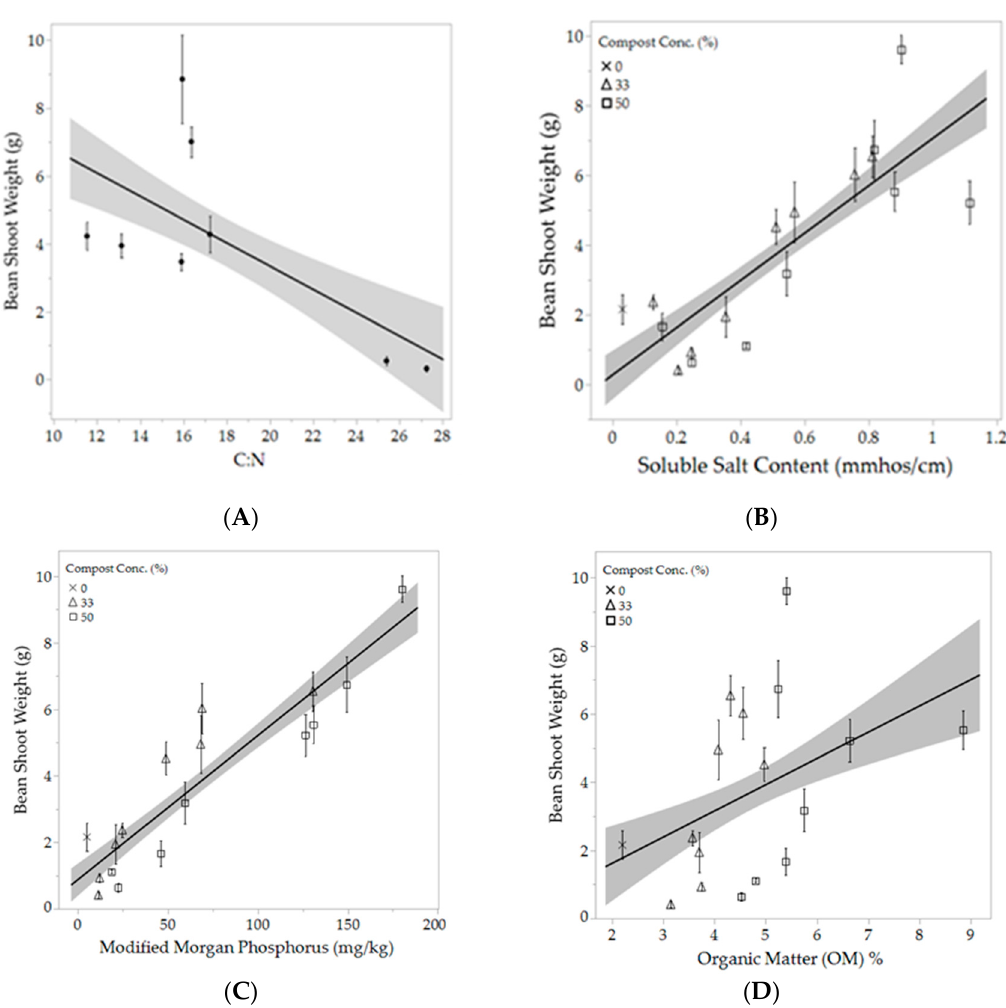
Figure 2. ( A ) shows the relationship between dry shoot weight of the bean plants and C:N ratio of eight of the nine compost types (excluding WCE). The black line represents the line of best fit; R 2 = 0.359. ( B ) displays the relationship between dry shoot weight of the bean plants and soluble salts concentration of the amended and unamended soil for all compost types (excluding WCE); R 2 = 0.570. ( C ) displays the relationship between extractable (available) phosphorus content of the amended and unamended treatments and bean dry shoot weight; R 2 = 0.698. ( D ) displays the relationship between dry shoot weight of the bean plants and OM% of the amended and unamended treatments (excluding WCE); R 2 = 0.157. The 100% compost treatments were excluded from Figure 2B–D for ease of interpretation. In all figures the shaded area denotes a 95% confidence interval. Each point represents the mean, error bars denote standard error (n = 6).